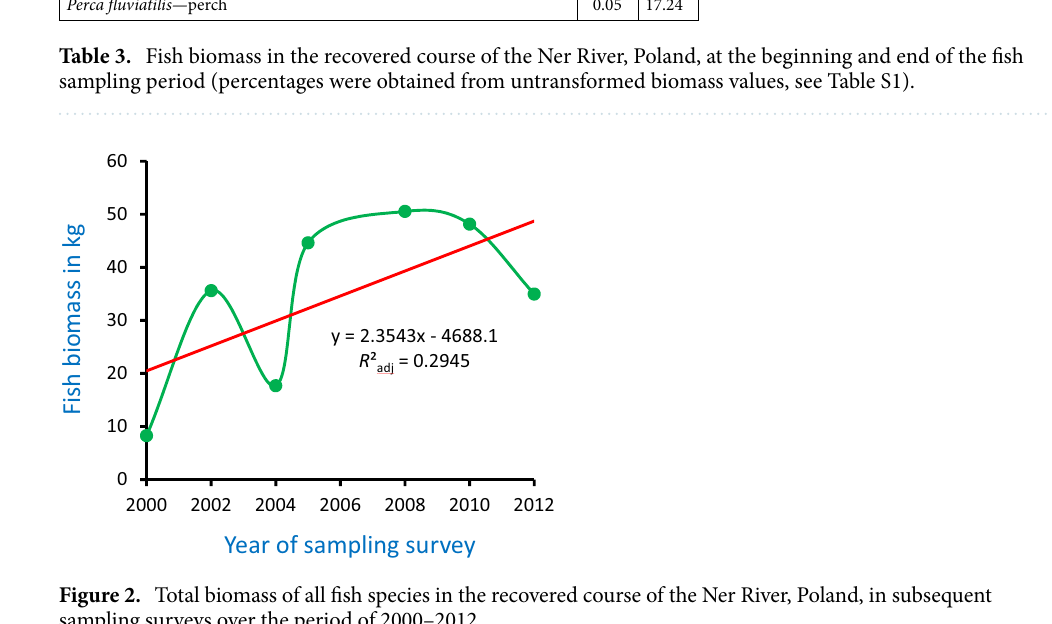
Figure 2. Total biomass of all fish species in the recovered course of the Ner River, Poland, in subsequent sampling surveys over the period of